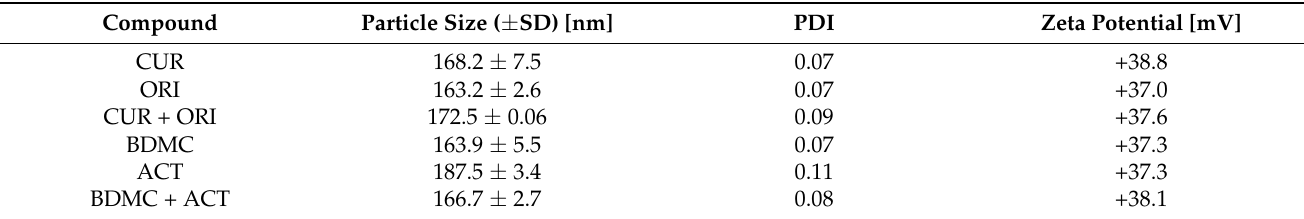
Figure 4. The size of the liposomes (with CUR, ORI, and mixture of CUR + ORI) was measured with dynamic light scattering (DLS). Table 1. The Particle Size, Polydispersity Index (PDI) and Zeta Potential of the